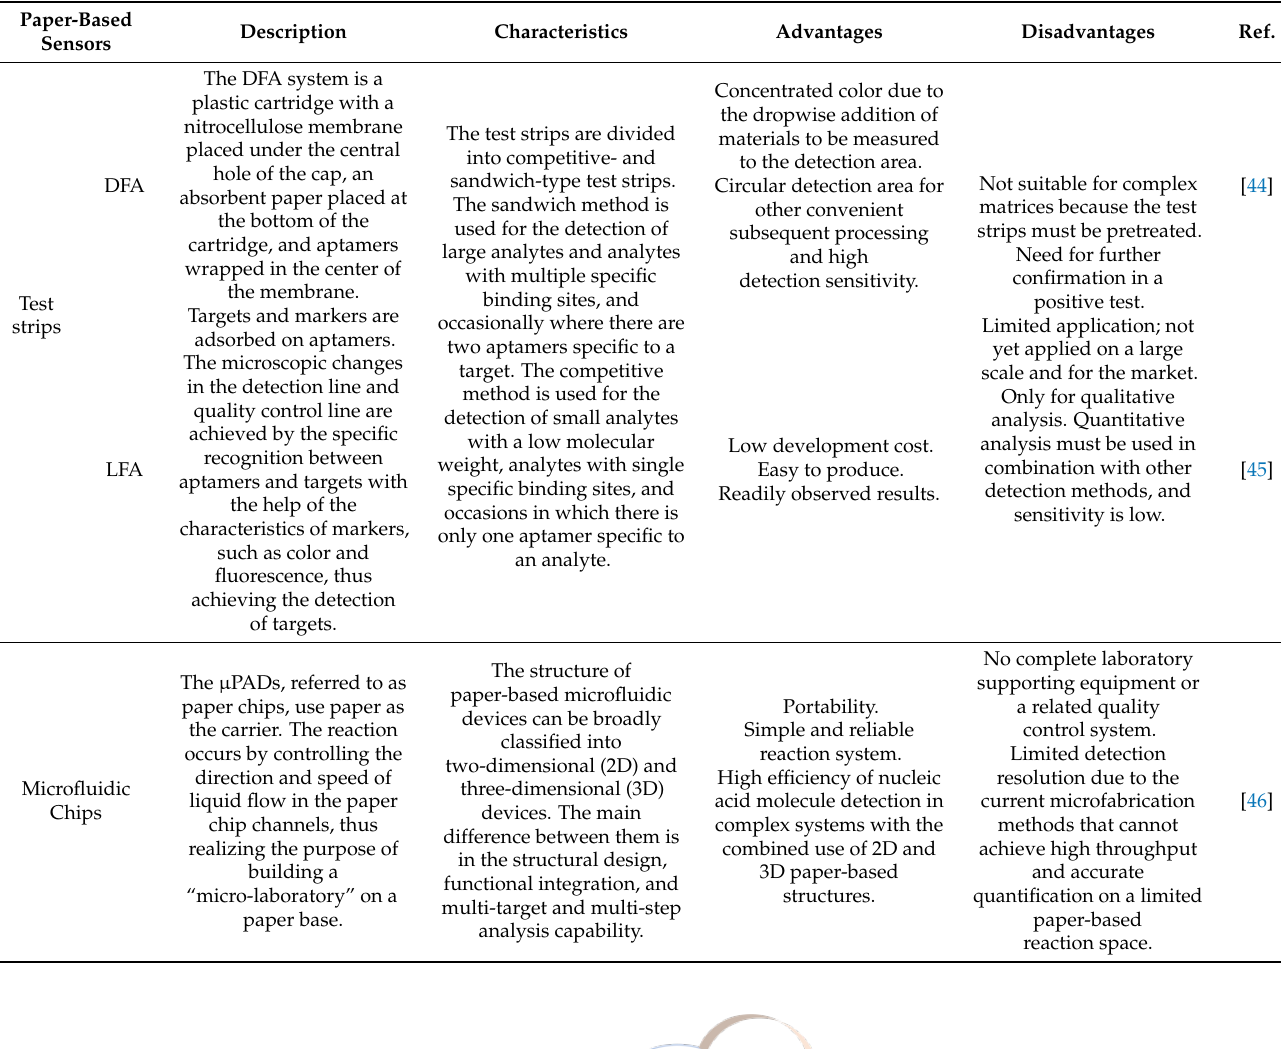
Table 2. Summary of paper-based sensors.